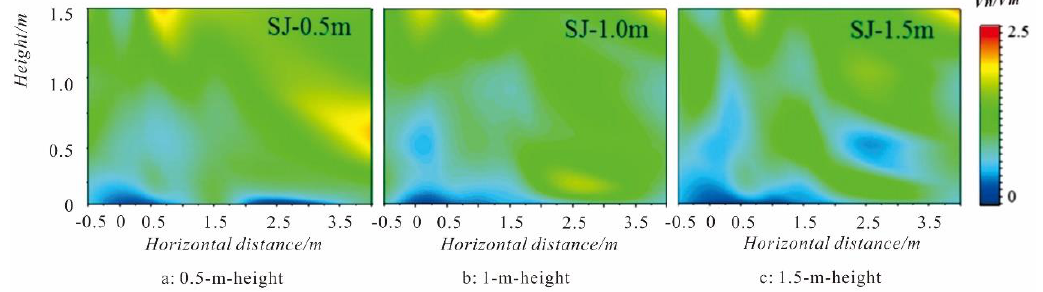
Figure 5. Airflow distribution for 0.5-m-height ( a ), 1-m-height ( b ) and 1.5-m-height ( c ) of H. rhamnoides. Table 1. The airflow decreases rate ( R ) and maximum windproof length of airflow ( L max ) for different heights of H. rhamnoides.